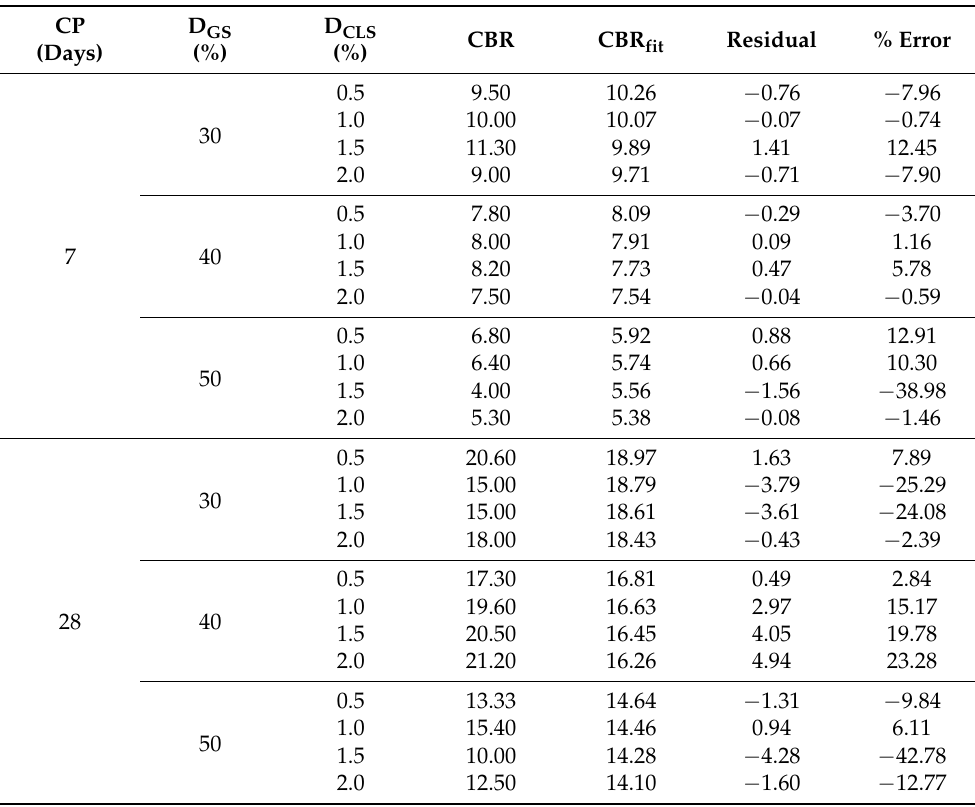
Table 3. The linear equation results for the California Bearing Ratio (CBR fit ) of soil treated with granite sand (GS) and calcium lignosulfonate (CLS) measured after 7 and 28 days of